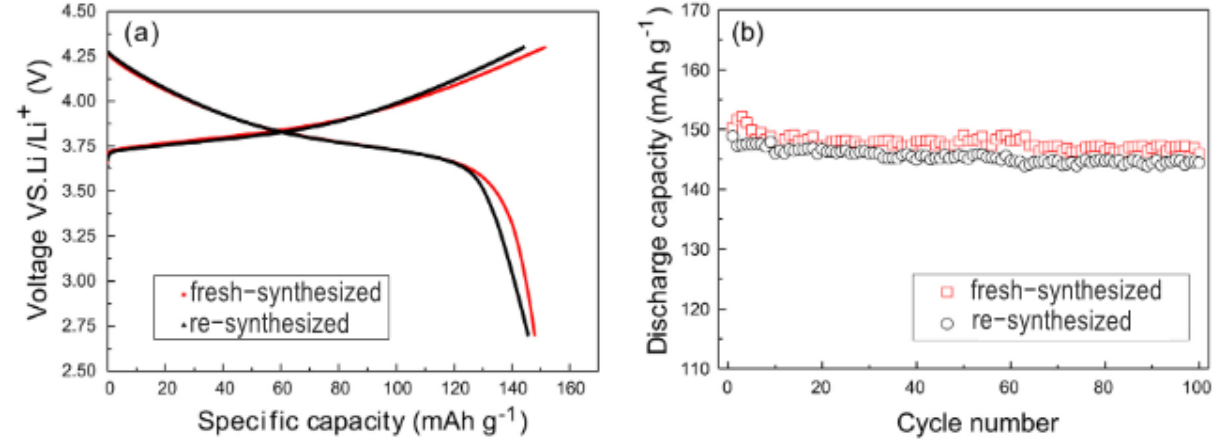
Figure 8. The initial charge–discharge curves ( a ) and cycling performance ( b ) of the fresh-synthesized and the regenerated NCM111 between 2.7 and 4.3 V at the 0.2 C rate [43]. Ref. [43] is an open